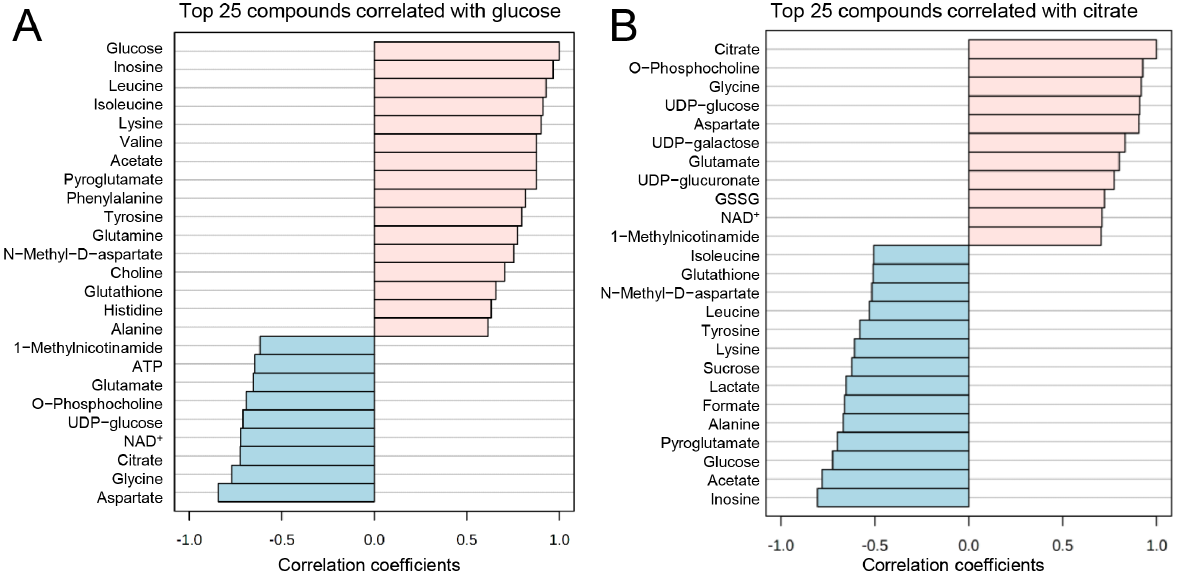
Figure 5. Pattern hunter analysis of glucose and citrate. ( A ) Glucose concentration pattern changes positively correlate (pink bars) with inosine, leucine, isoleucine, lysine, valine, acetate, pyrogluta- mate, phenylalanine, tyrosine, glutamine, N-methyl-D-aspartate, choline, glutathione, histidine, and alanine, while negatively correlate (blue bars) with aspartate, glycine, citrate, nicotinamide adenine dinucleotide (NAD) + , uridine diphosphate (UDP)-glucose, O-phosphocholine, glutamate, adenosine triphosphate (ATP) and 1-methylnicotinamide. ( B ) Citrate positively (pinks bars) correlates with O-phosphocholine, glycine, UDP-glucose, aspartate, UDP-galactose, UDP-glucuronate, oxidized glutathione (GSSG), NAD + , and 1-methylnicotinamide; and negatively (blue bars) correlates with inosine, acetate, glucose, pyroglutamate, alanine, formate, lactate, sucrose, lysine, tyrosine, leucine, N-methyl-D-aspartate, glutathione, and isoleucine concentration patterns, based on Pearson r distance measure ( n = 4, two-group comparison).